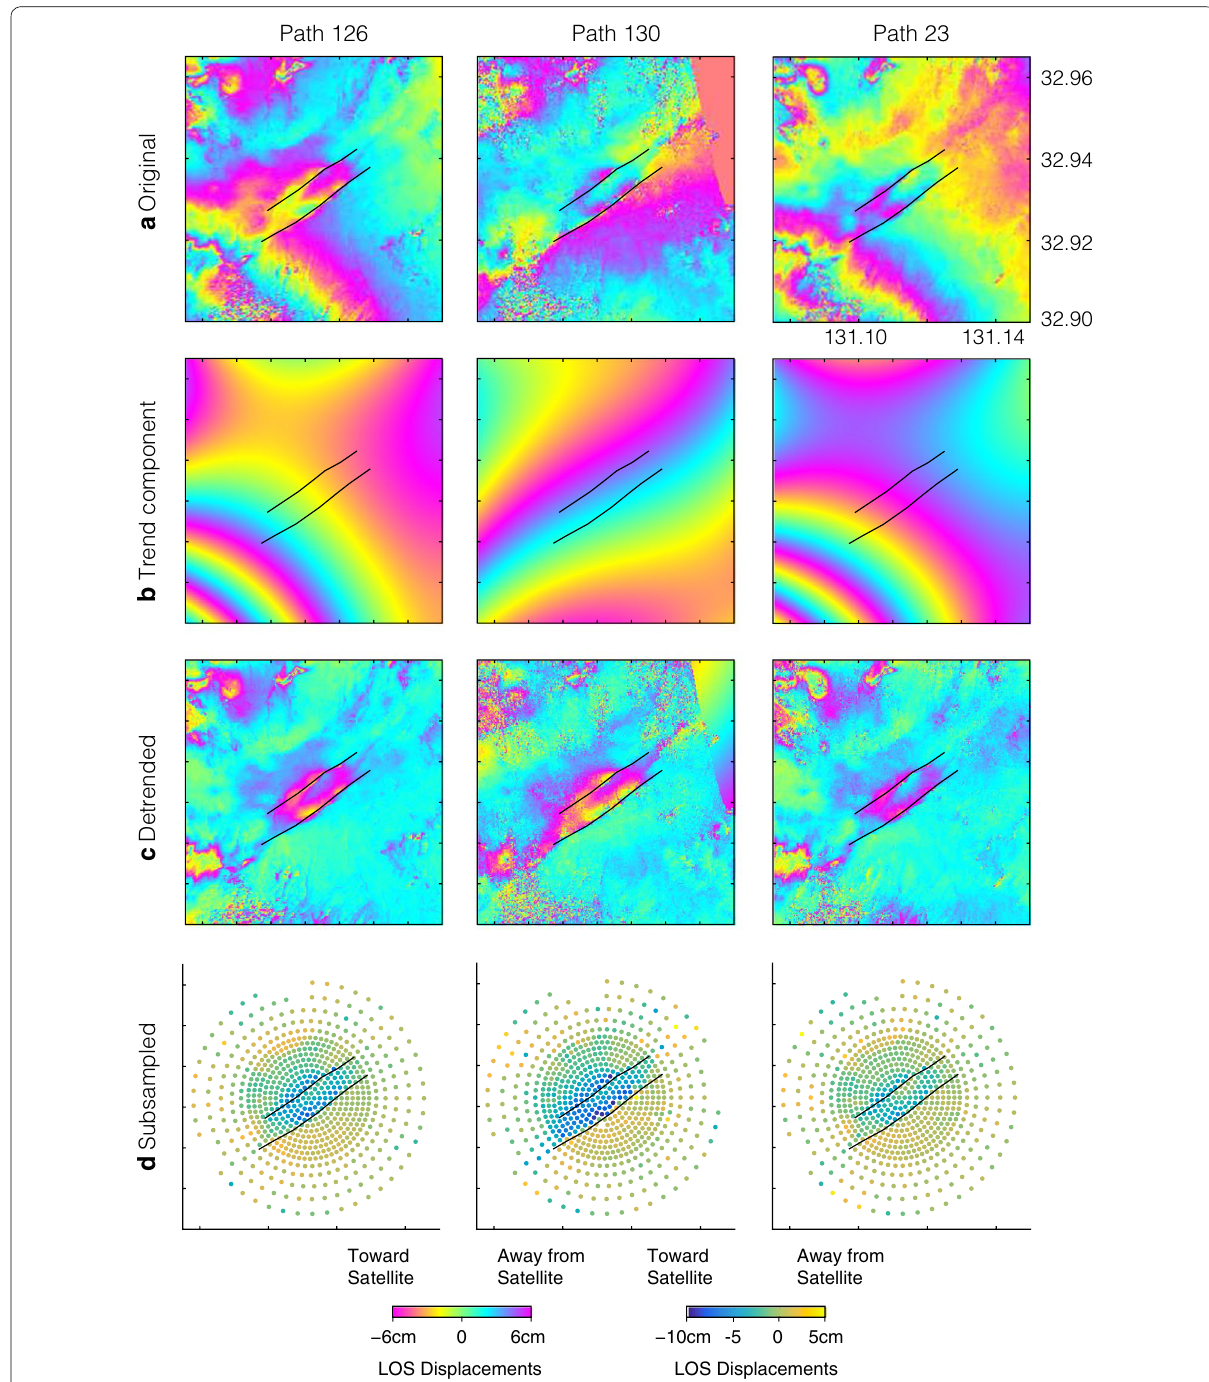
Fig. 6 a Original, b estimated trend, c detrended, and d subsampled data for the three data sets. For a – c , the data are shown rewrapped for better visibility. Black curves correspond to the top of the assumed fault planes. Local variations in areas isolated from the faults in c were assumed to be unrelated to the faulting and were not used in the subsampled data sets ( d